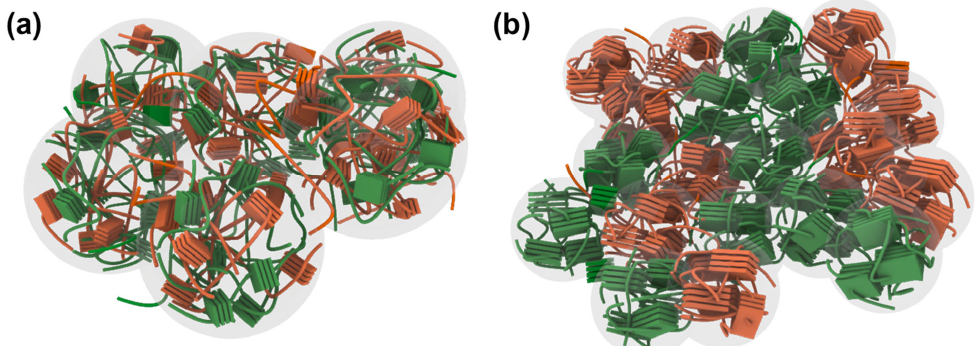
Figure 13. Schematic drawing of ( a ) randomly aggregated polymer blends representing the blend films processed from XY, XY + TMB, and XY + IN solutions and ( b ) polymer blends with internet ‐ worked p ‐ type polymers representing the blend films processed from XY + TN and XY + DPE solu ‐ tions. p ‐ type and n ‐ type polymers are presented by green and orange colors, respectively, and the aggregated domains are presented by light gray circles.